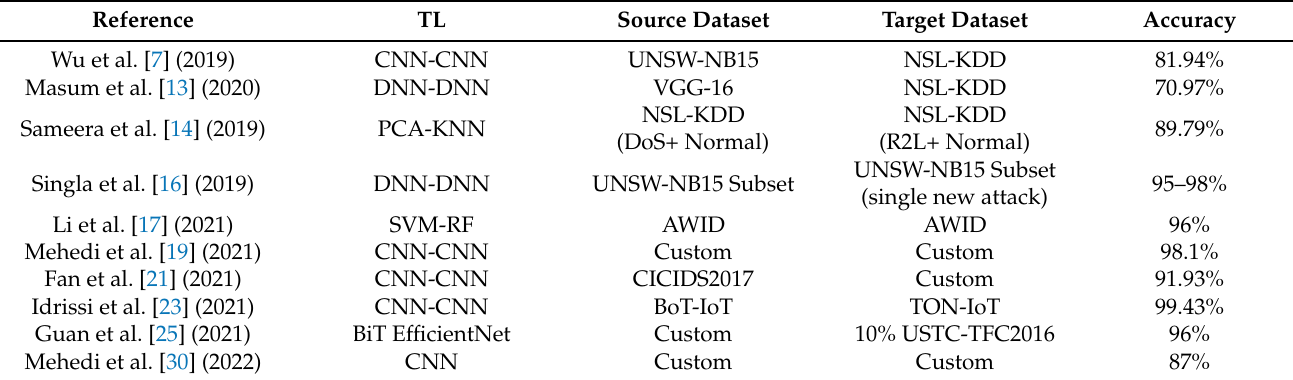
Table 1. Transfer-learning-based intrusion detection in IoT